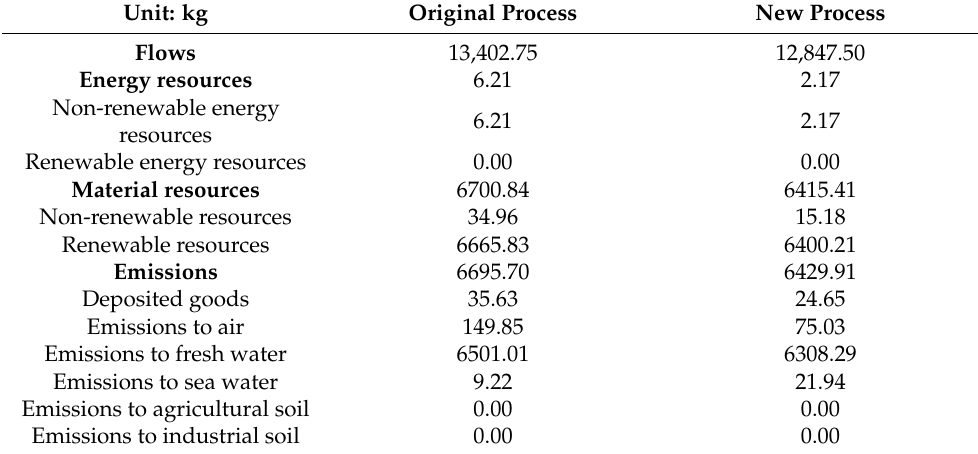
Table 4. Life cycle resource depletion and emissions comparison of the silver separation processes. Unit: kg Original Process New Process